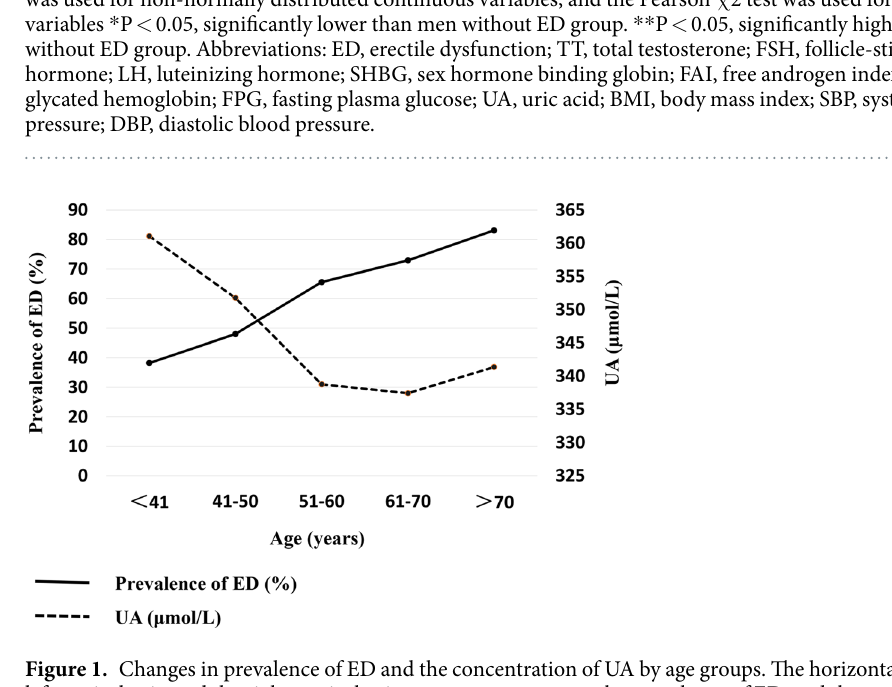
Table 1 summarized the general demographic and laboratory characteristics of the participants who were divided into two groups according to whether the investigators were suffering from ED or not. A total of 1365 men met the inclusion criteria for this study with an overall mean age 55.5 ± 10.8 years (range: 20–83 years). Compared with the men without ED, the men in ED group were older and had significantly lower serum UA levels, higher glycated hemoglobin (HbA1c), fasting plasma glucose (FPG) and systolic blood pressure (SBP) levels. Moreover, the ED group possessed a higher prevalence of diabetes. As to the sex-related hormones, the men with ED had significantly lower free androgen index (FAI) and higher sex hormone-binding globulin (SHBG), follicle-stimulating hormone (FSH) and luteinizing hormone (LH) levels. Differences in total testosterone (TT), body mass index (BMI) and diastolic blood pressure (DBP) levels were not statistically significant between the two groups. Figure 1 illustrated the prevalence of ED and the concentration of serum UA across age groups. Overall, the prevalence of ED was 62.4% (51.4% standardized by age, referred to the 6 th national population census data, www.